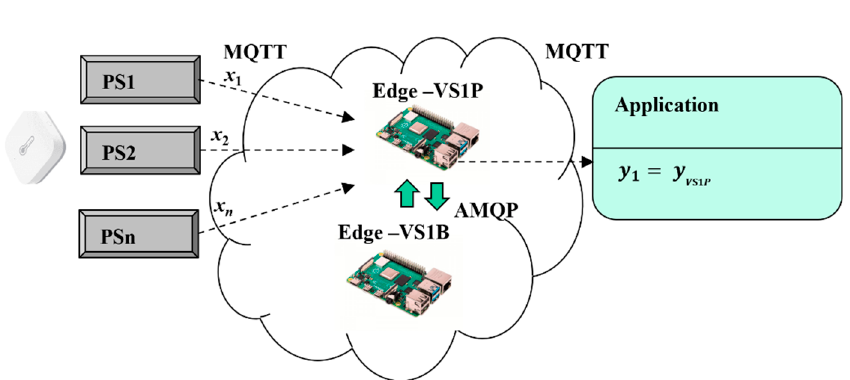
Figure 5. Virtual redundant sensor model with mirroring.